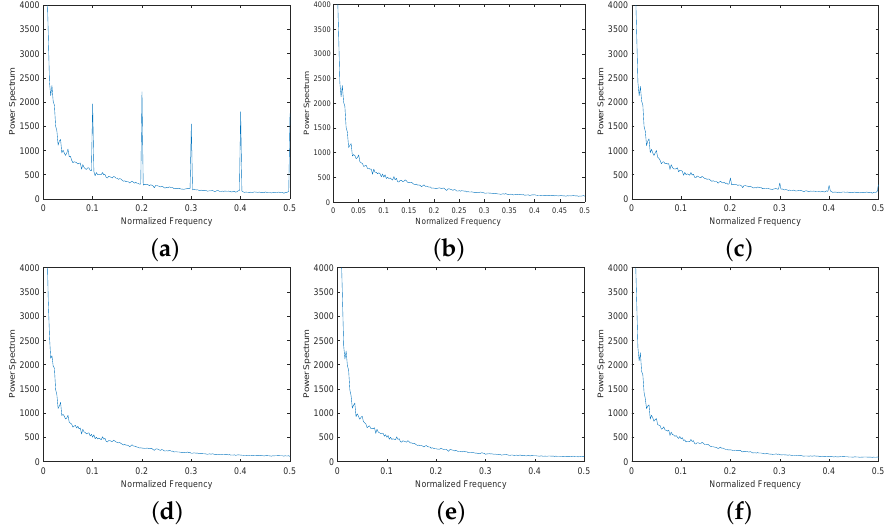
Figure 18. Pow spectrums of Figure 13. ( a ) Original image; ( b ) WAFT; ( c ) SLD; ( d ) GSLV; ( e ) LRSID; ( f ) the proposed